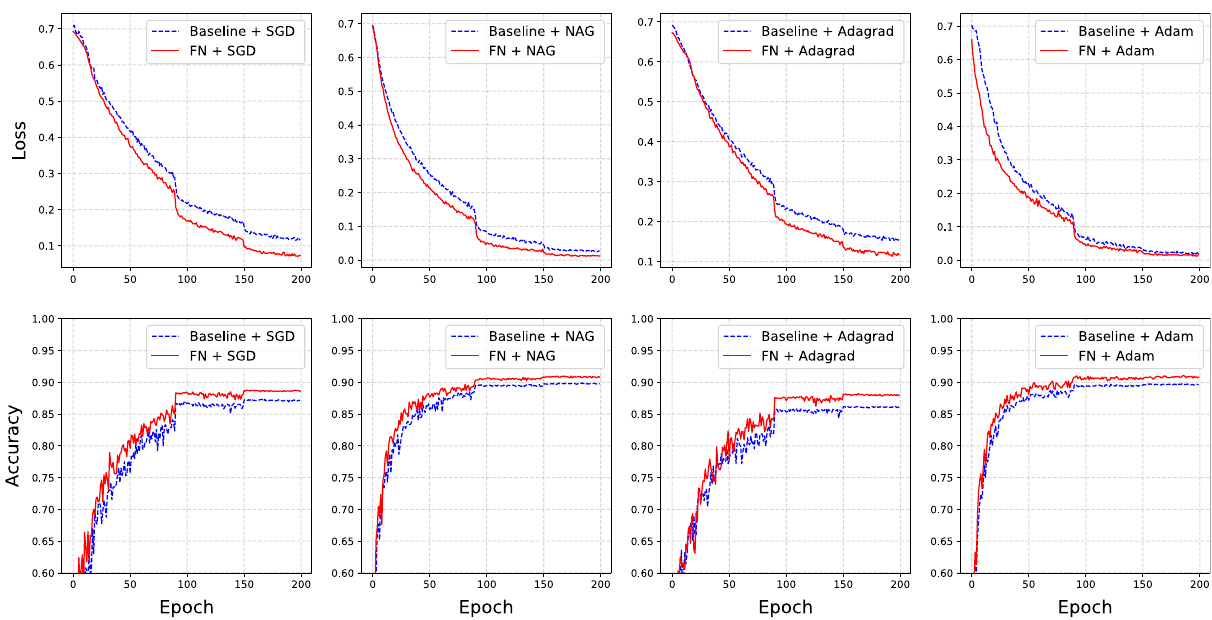
Figure 5. Results of training ResNet50 on CatDog dataset. The top panel shows the training loss of the baseline (blue dashed line) and FN models (red solid line) with four different optimizers. The bottom panel shows the testing accuracy of the baseline (blue dashed line) and FN models (red solid line) with different optimizers. The curves represent the median training loss and testing accuracy of ten repeated